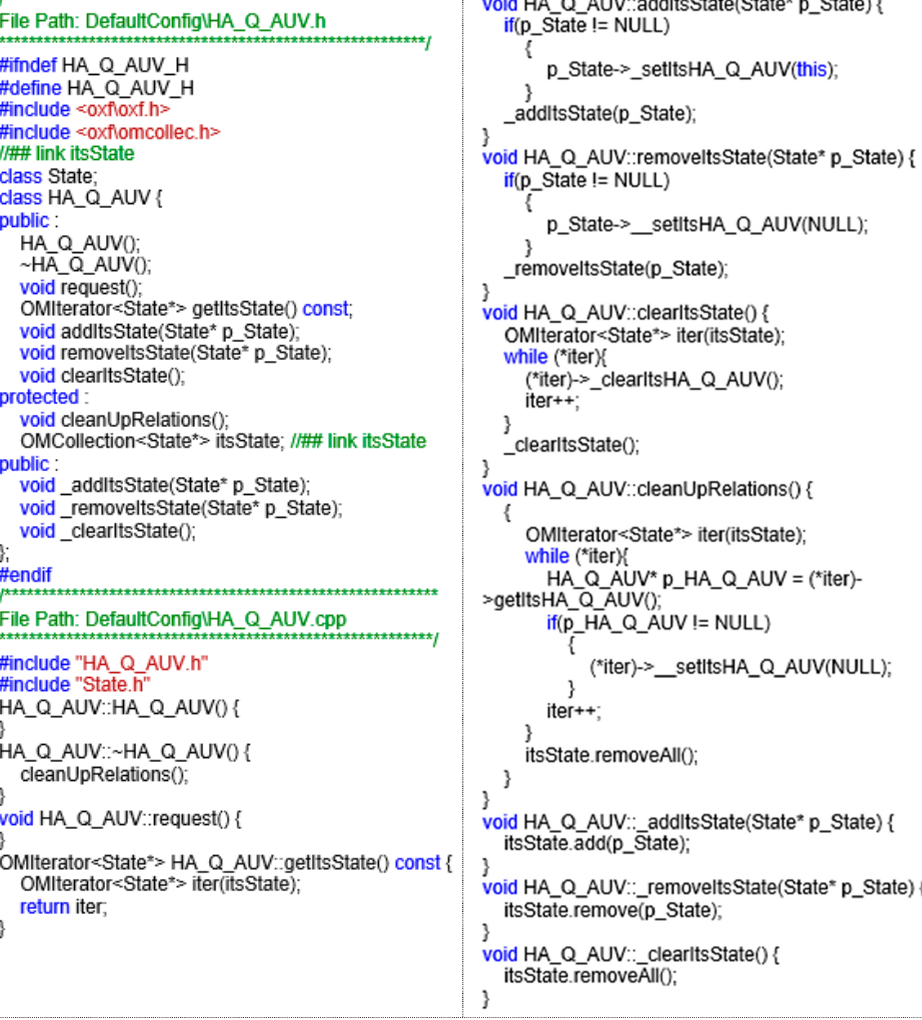
Figure A1. An example of HA implementation based on the state pattern.